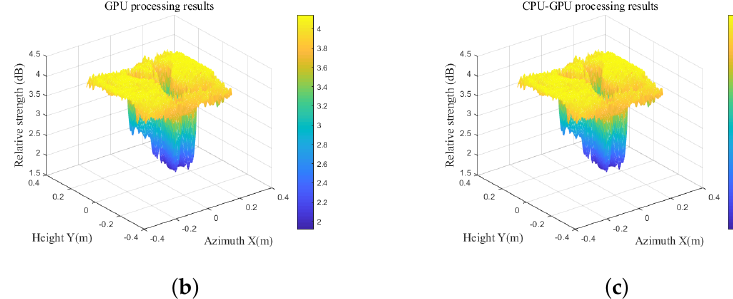
Figure 9. Amplitude-level comparison. ( a ) is the imaging target energy map obtained by the CPU- only method; ( b ) is the imaging target energy map obtained by the GPU-only method; and ( c ) is the imaging target energy map obtained by the proposed